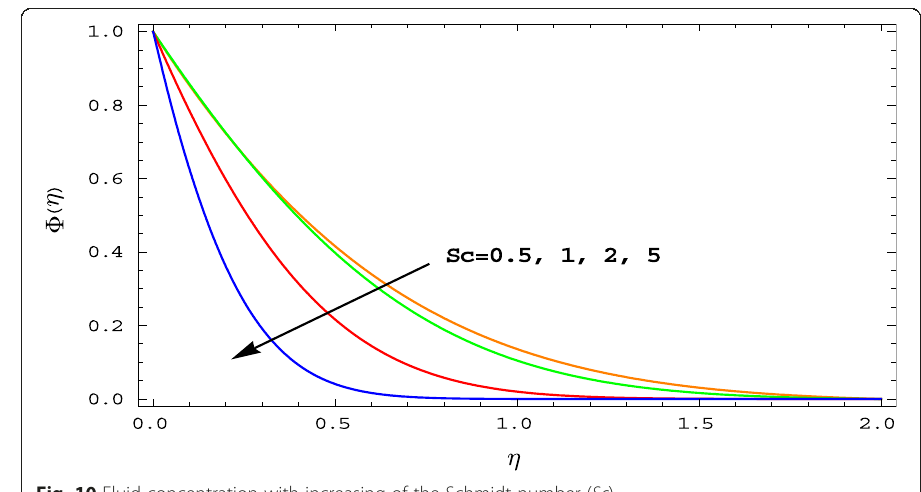
Fig. 10 Fluid concentration with increasing of the Schmidt number ( Sc )